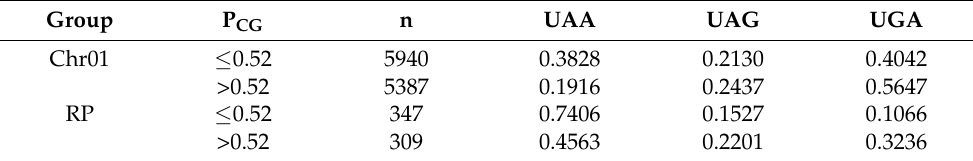
Table 6. Highly expressed genes prefer UAA stop codon. Human chromosome 1 (Chr01) contains 11,327 coding sequences (CDSs, including splicing isoforms), which is divided into two groups based on proportion of nucleotides C and G (P CG ) in the CDS. Stop codon usage of these CDSs change with P CG and differ from highly expressed ribosomal protein genes (RP, including splicing isoforms). Group P CG n UAA UAG UGA Chr01 ≤ 0.52 5940 0.3828 0.2130 0.4042 >0.52 5387 0.1916 0.2437 0.5647 RP ≤ 0.52 347 0.7406 0.1527 0.1066 >0.52